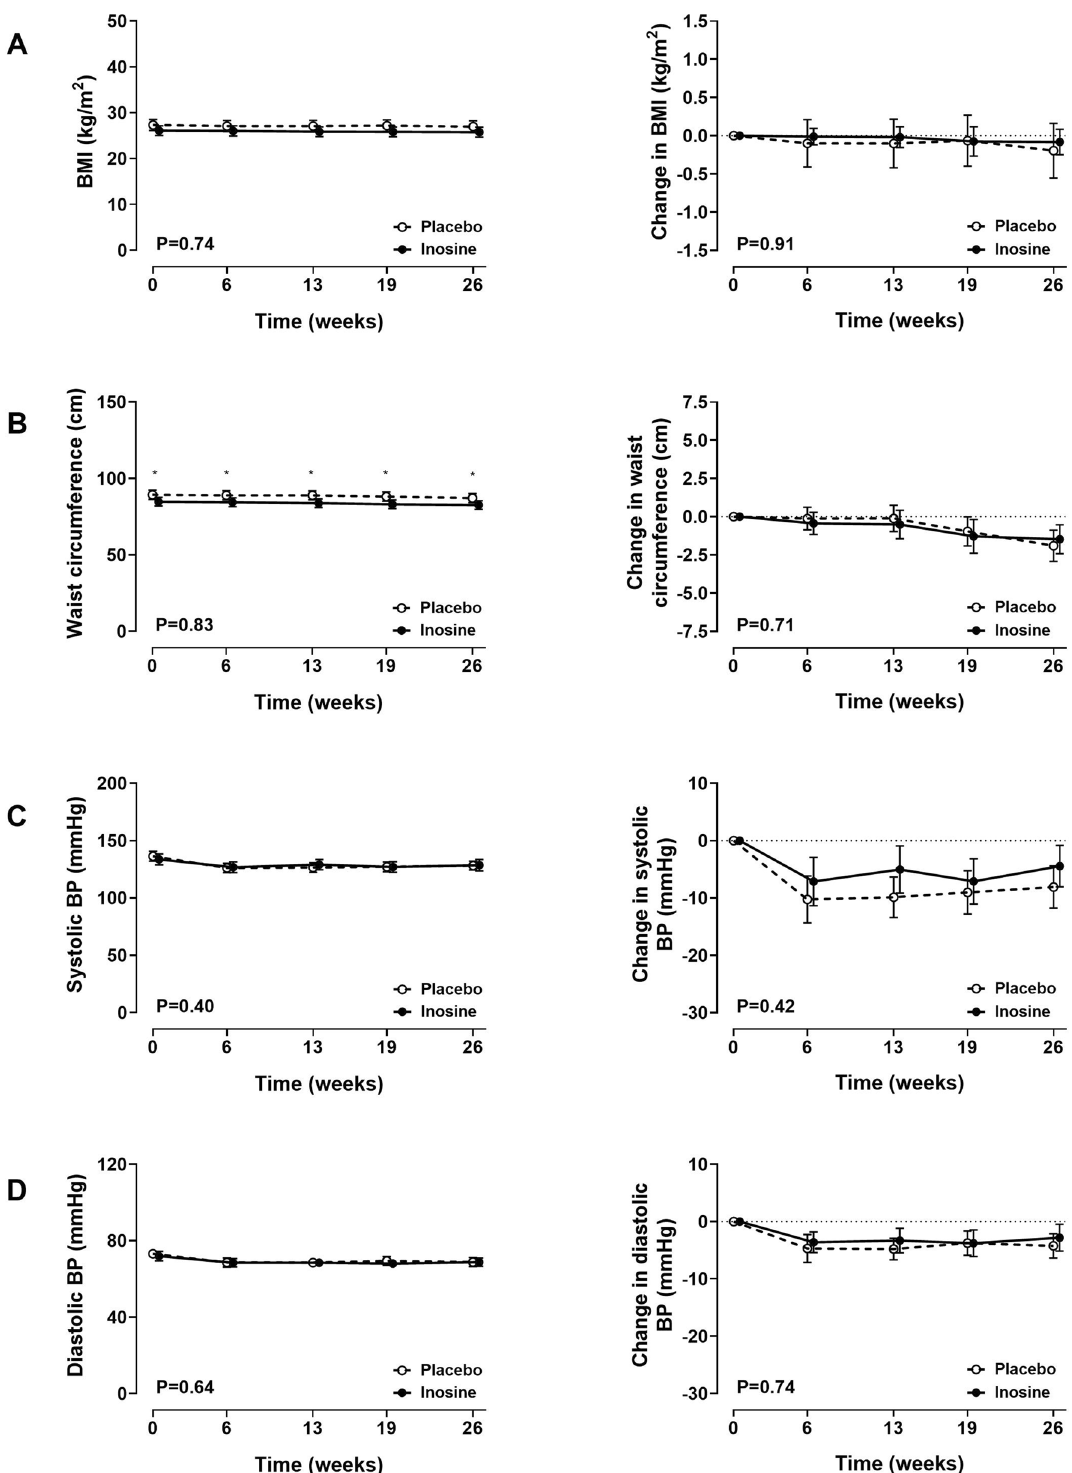
Figure 2. Physical measurements and blood pressure. Absolute values (left panel) and change from baseline (right panel). ( A ) Body mass index; ( B ) waist circumference; ( C ) systolic blood pressure; ( D ) diastolic blood pressure. Data are shown as mean (95% CI), with P time×treatment . False discovery rate *P <